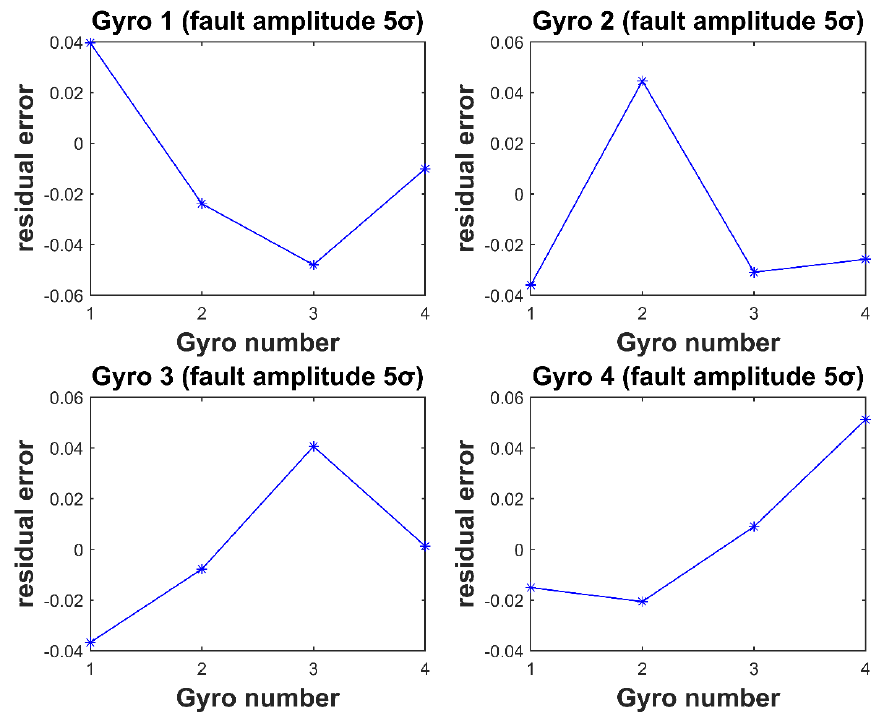
Figure 4. Residual vector values for Gyro 1–4 injection of 10  fault amplitude.